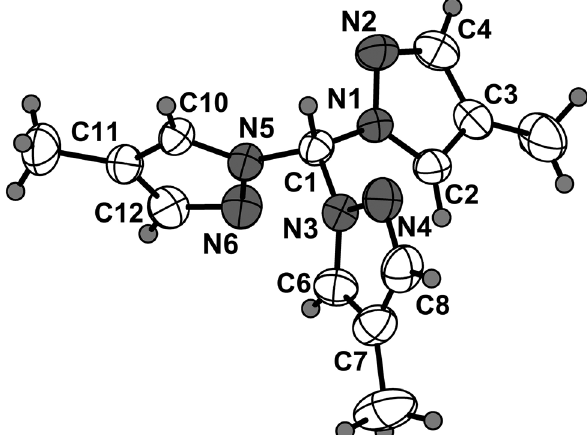
Table  : Data collection and